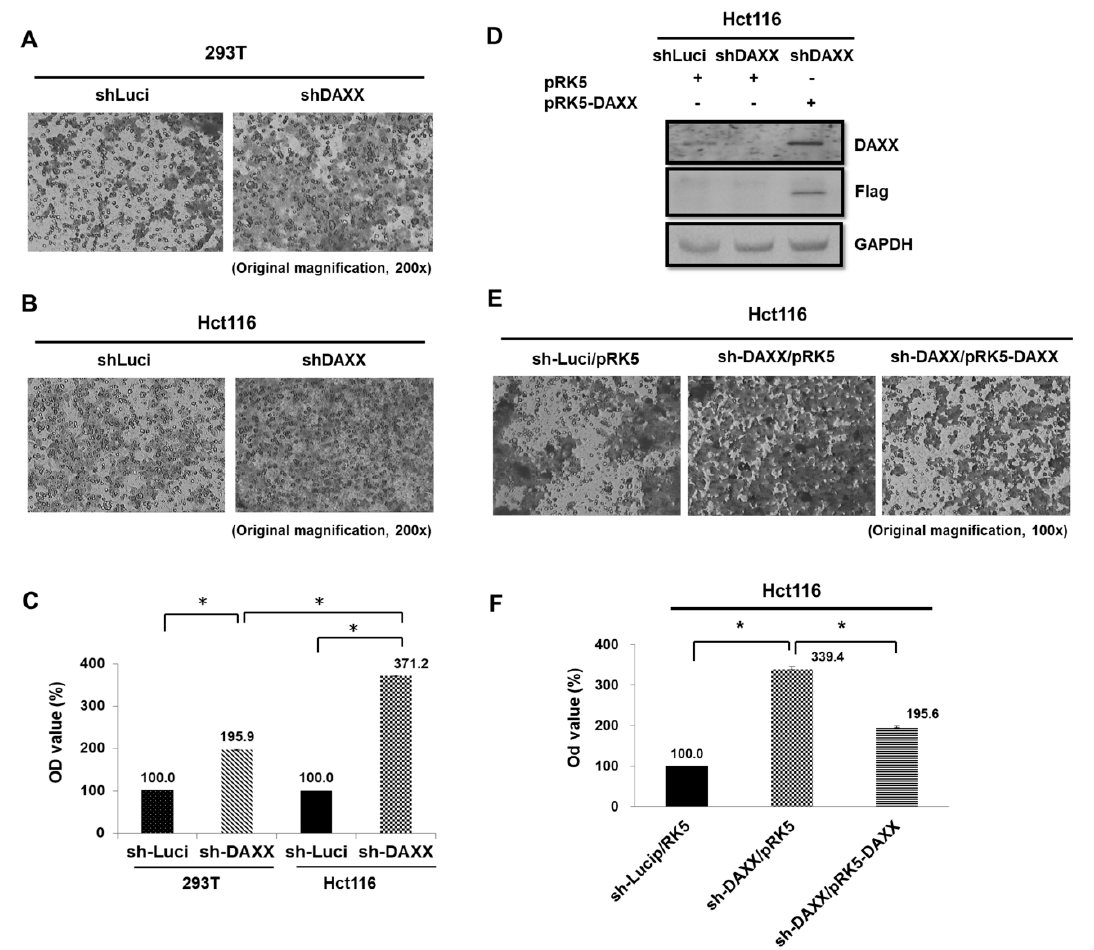
Figure 3. Effects of DAXX knockdown on CRC cell migration. ( A–C ) In Transwell migration assay, 4 × 10 5 293T cells and Hct116 cells plated onto a 24-well plate for 48 h. DAXX knockdown promoted cell motility in Hct116 cells more than in 293T cells. Luciferase-knockdown CRC cells control were evaluated as negative controls. ( D , E ) In addition, transfection of pRK5-DAXX into Hct116 cells of shDAXX decreased cancer cell migration so that DAXX change was reversed for cell migration in Hct116 cells. * p < 0.05, Student t test; n.s. = nonsignificant. Magnification, 200 × ( A , B ) and 100 × ( E ).